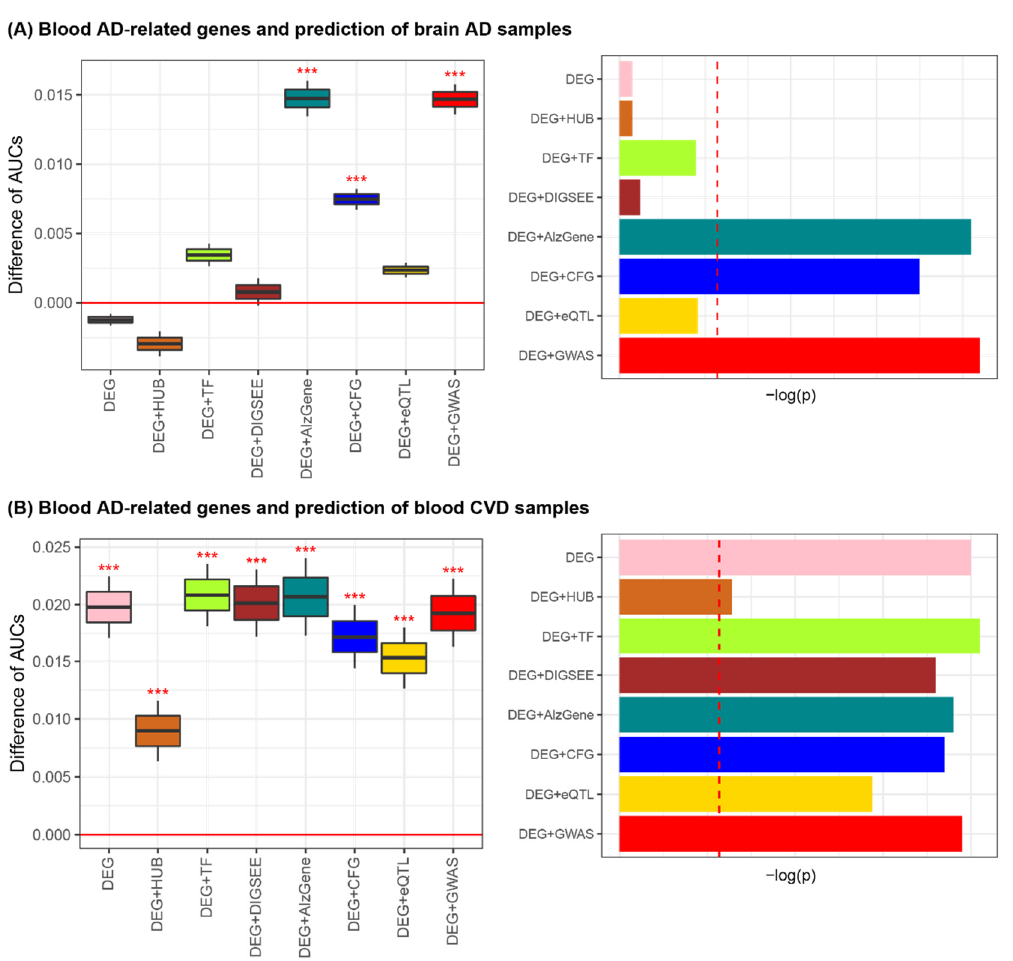
Figure 4. Blood AD-related genes and prediction of the brain AD ( A ) and blood CVD samples ( B ). *** p < 0.001, ** p < 0.01, and * p < 0.05. Red dashed vertical lines in the bar plots on the right-side indicate the value of − log(Bonferroni-corrected p -value of 0.05 = nominal p -value of 0.00625 (=0.05/8)). AD, Alzheimer’s disease; CVD, cardiovascular disease; AUC, area under the receiver operating characteristic curve; DEG, differentially expressed gene; TF, transcription factor; CFG, convergent functional genomics; eQTL, expression quantitative trait loci; GWAS, genome-wide association study.